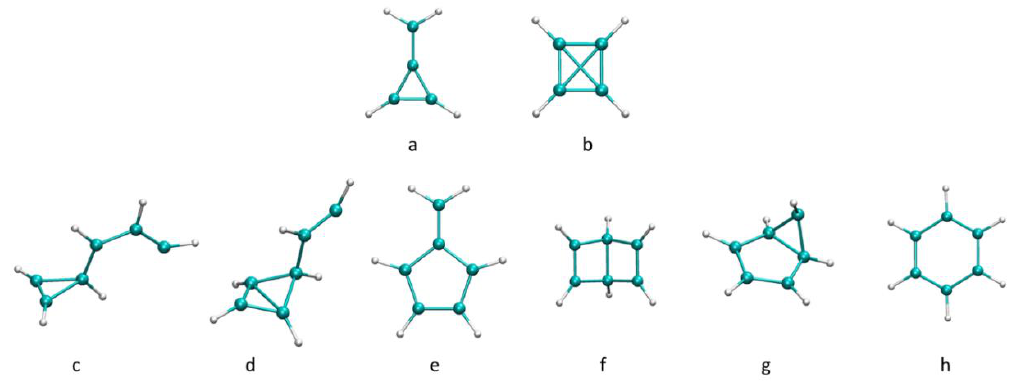
Figure 3. Optimized bonded C 4 H 4+ and C 6 H 6+ core structures. (a,b) : isomers on the C 4 H 4+ PES. (c–h) : isomers on the C 6 H 6+ PES.